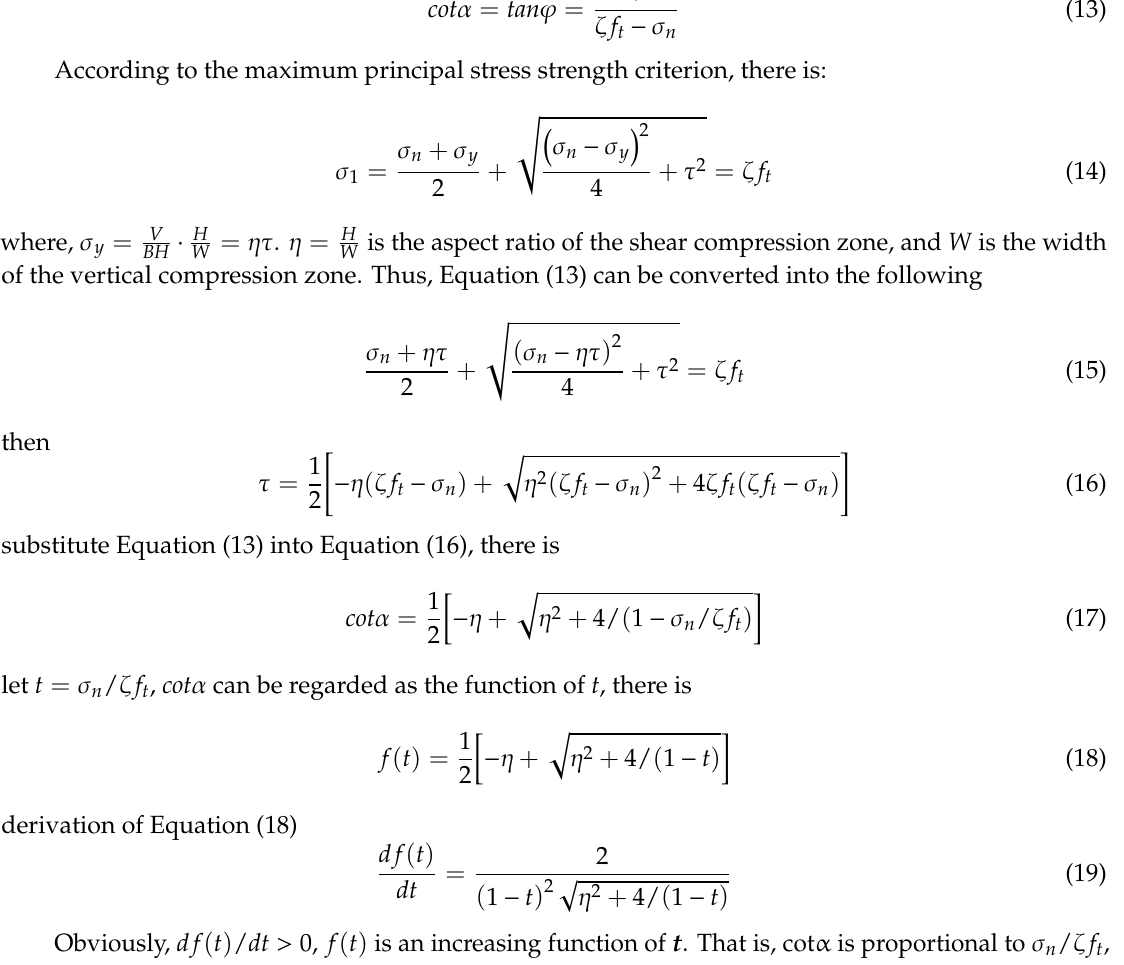
Table 5. The corresponding calculated results obtained by di ff erent formulas are listed in Table